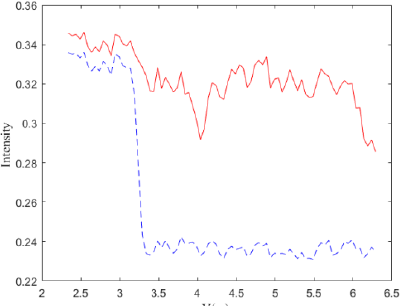
Figure 4. Intensity profiles along the Y axis, i.e. the along flume direction. The red solid line is the profile of the dry point cloud; the blue dashed line is the profile for the corresponding wet point cloud. A intensity value at a given Y location is obtained by averaging intensities for all corresponding X